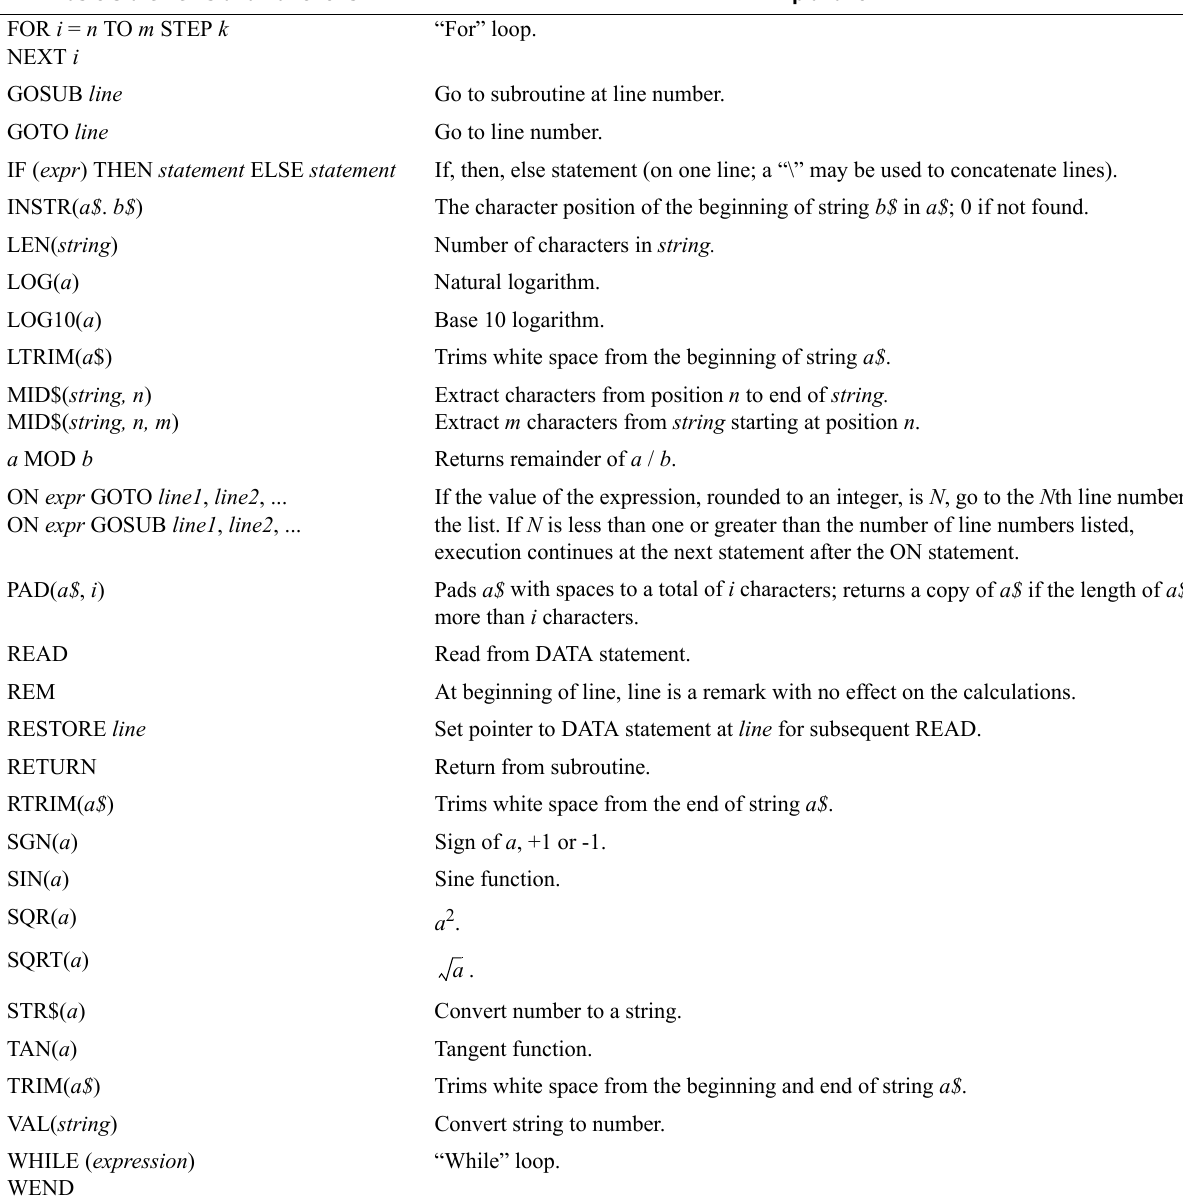
Table 7. Standard Basic statements and